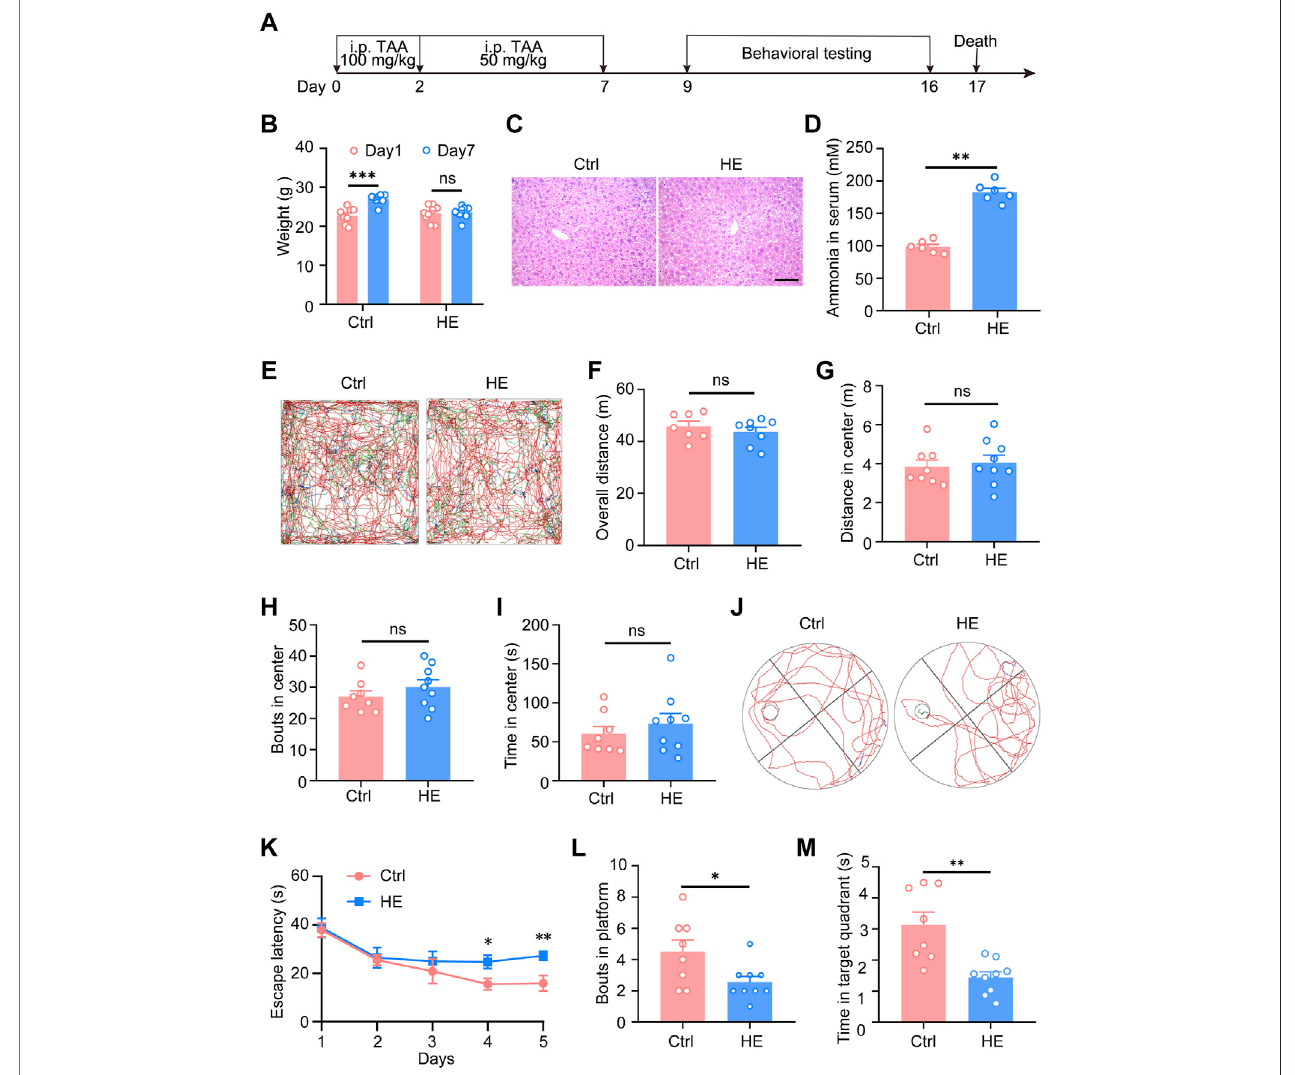
FIGURE 1 | Modeling and identi fi cation of mice with hepatic encephalopathy. (A) Schematic of experimental procedures. At the age of 7 weeks, the HE mice received 100 mg/kg TAA intraperitoneal injections daily on the fi rst and second days and then 50 mg/kg TAA daily from the third to the seventh day. From day 9 to day 16, perform behavioral tests, subsequently, the mice were sacri fi ced on day 17. (B) Body weight analysis of mice during the modeling period. (C) Representative photomicrographs of Hematoxylin-eosin staining in liver sections. Scale bar, 100 μ m. (D) Changes in serum ammonia concentration in two groups of mice. (E) Representativetracesof10 mininopen fi eldtests.EffectofHEontotaldistancetraveled (F) ,centralareamovementdistance (G) ,boutsinthecenter (H) ,anddurationin thecenter (I) intheopen- fi eldtestonmice( n =8miceforcontrol; n =9miceforHE; p > 0.05). (J) RepresentativetracesofMorriswatermazetest. (K) Duringthelearning phaseoftheMWM,theescapelatencytotheplatformofthetwogroupsofmicewassigni fi cantlydifferent( p =0.0035),whereHEmicetooksigni fi cantlylongerto fi ndthe platform thancontrolmice. (L) Platform crossing times ( p = 0.0307) and (M) time spent at target quadrant ( p =0.0014)were signi fi cantlylower than inthe controlgroup. Data were shown as mean ± SEM. * p < 0.05, ** p < 0.01, *** p < 0.001; ns, no signi fi cant